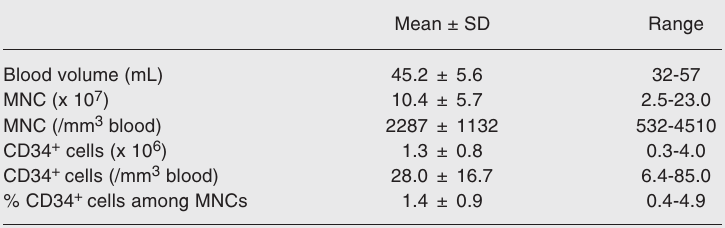
Figure 1. Effect of different com- binations of growth factors on cell proliferation after 4 and 7 days in culture. Sixteen different units of cord blood were used, and samples 2, 3, 4 and 11 were split into two different cultures (a and b ) , using 2 combinations of growth factors. TPO = thrombo- poietin; FL = FLT-3 ligand; KL =